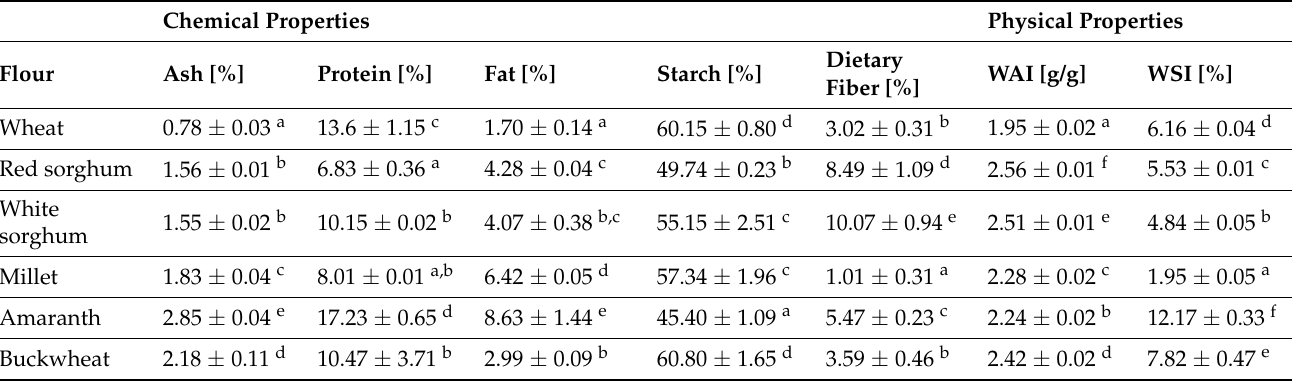
Table 1. Ash, protein, fat, and starch contents of raw flours used for